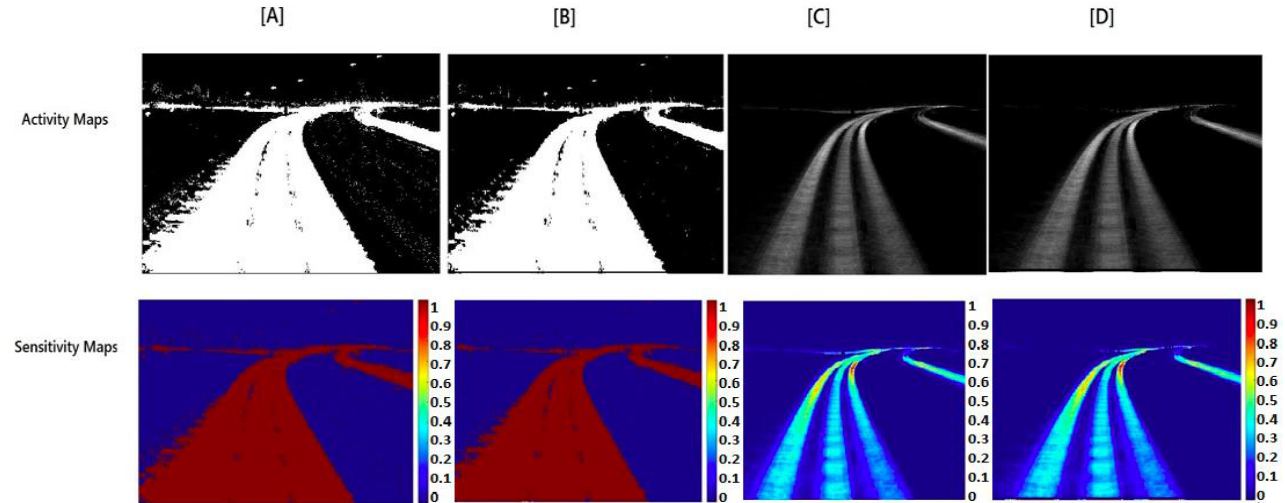
Figure 6. Simulation from video dataset 2 by the proposed framework (( a ) extracted frames in gray- scale, ( b ) foreground by adaptive background subtraction post-binarization and ( c ) optical flow).